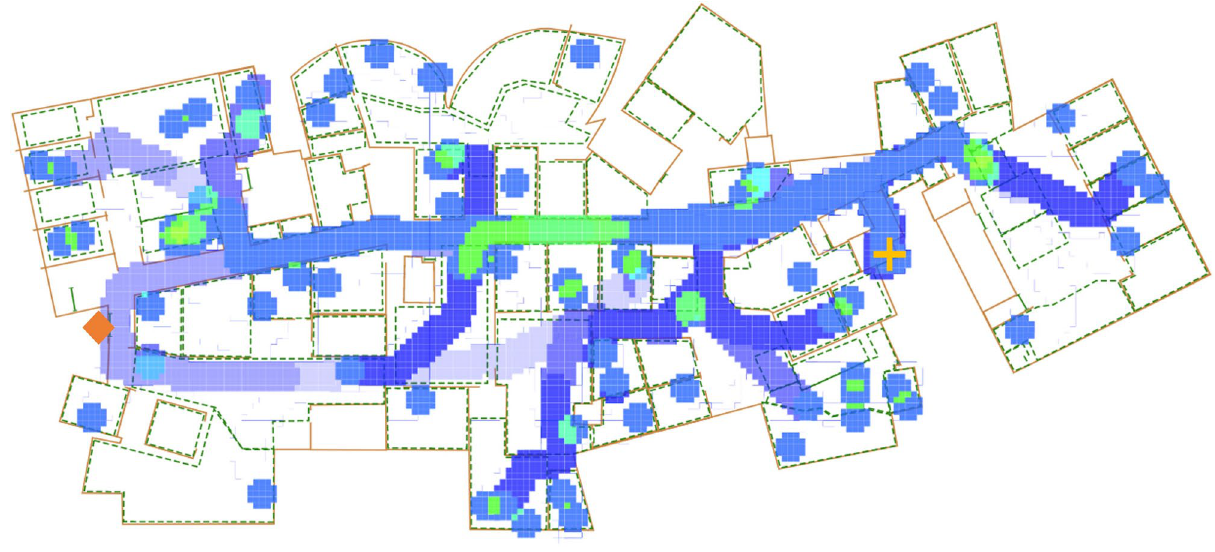
Figure 3. Example run of the spatial agent-based model with one-way movement restriction enabled. A heatmap depicting agent movement through the simulated floor is overlayed (lighter colors showing where agents have recently spent more time at). The designated entrance is marked with a yellow plus symbol and the designated exist is marked with an orange diamond symbol. In unrestricted movement, both these locations can be used for both entrance and exit to the